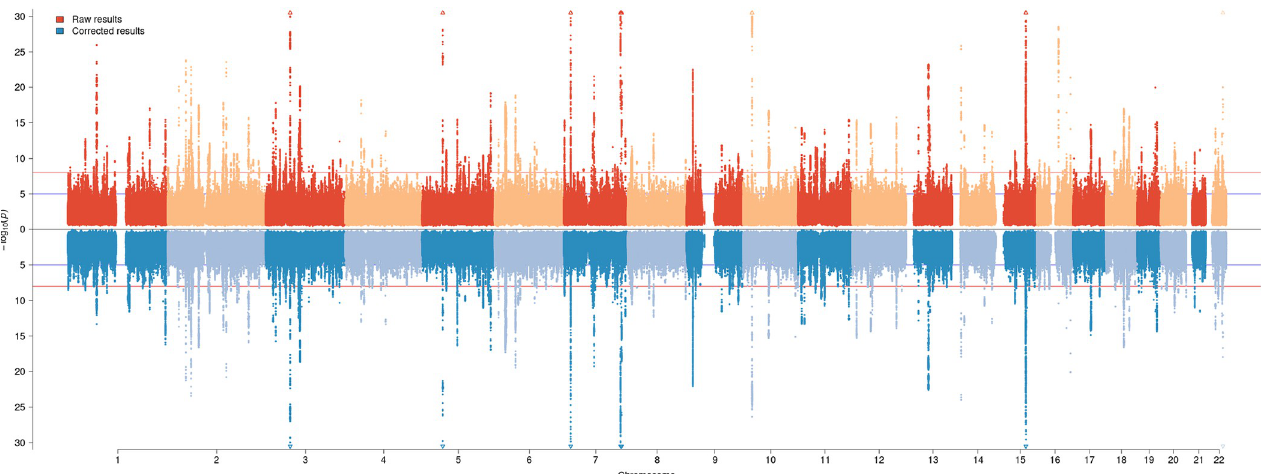
Fig 4. 302 independent genomic loci associate with food choices. Results for both univariate (256 loci) and PC traits (additional 27 loci see paragraph S2.3) analyses are included. For each SNP the lowest uncorrected p-value for all traits was plotted. The upper panel represents the unadjusted GWAS associations while the lower panel represents the association with food choices, after adjustment for mediating traits, such as health status for the same snp-trait pair used for the upper panel.